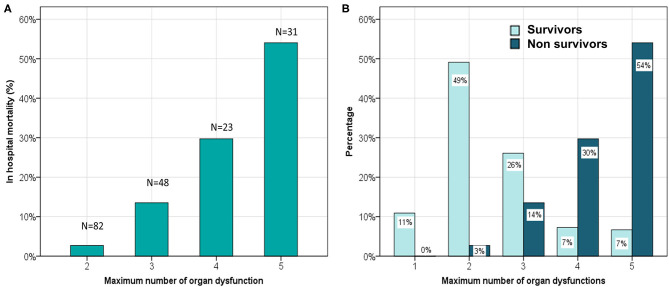
(A) Comparison of hospital mortality and the maximum number of concurrent organ system dysfunctions. (B) Comparison of maximum number of concurrent organ system dysfunction among survivors and non survivors.